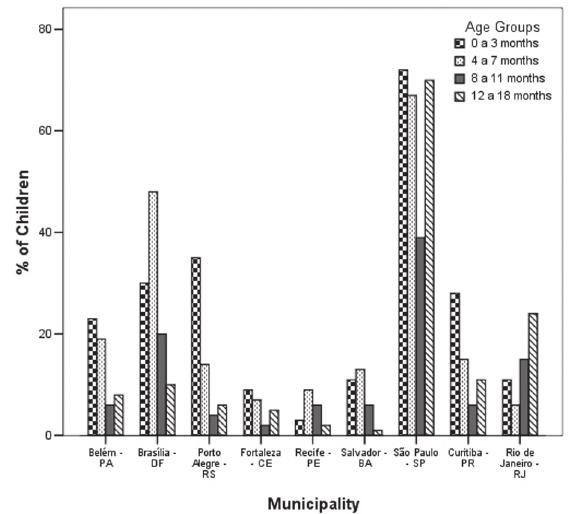
Figure 1 - Distribution of the total number of children that participate in this multicenter study according to their